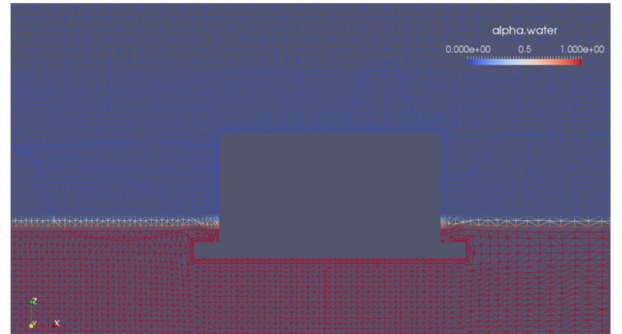
Figure 4. Mesh details generated by